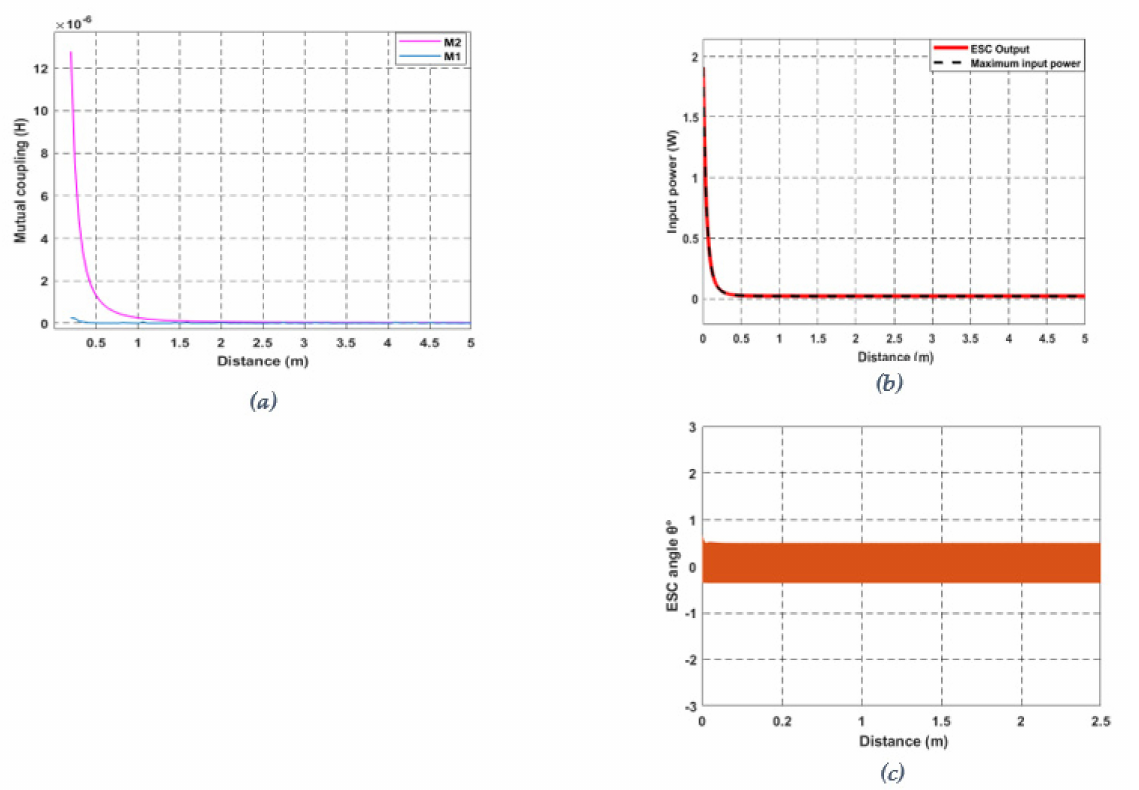
Figure 19. Continuous distance variation of the receiver when α is fixed at 0 ◦ . ( a ) Mutual coupling in terms of the receiver distance variation d . ( b ) Input power maximum tracking under a continuous distance variation. ( c ) Optimum magnetic resultant angle θ searched by the ESC when the distance is varying